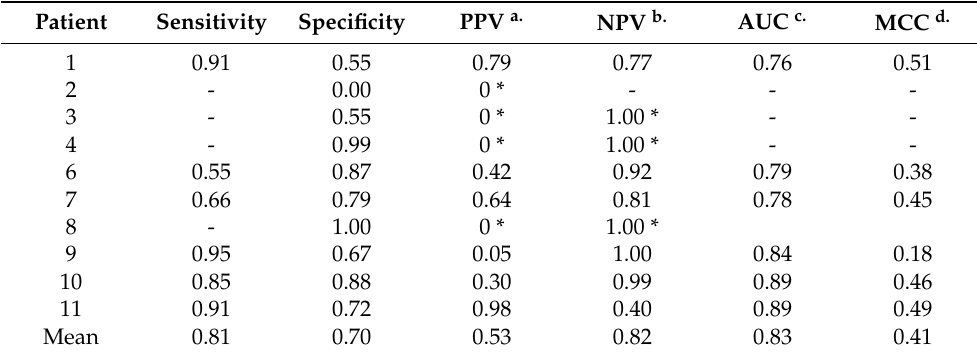
Table 3. Classification result of leave-one-out